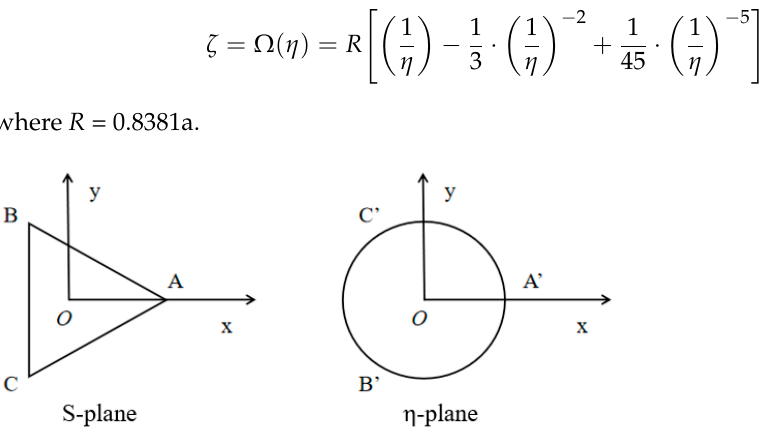
Figure 2. Conformal mapping.